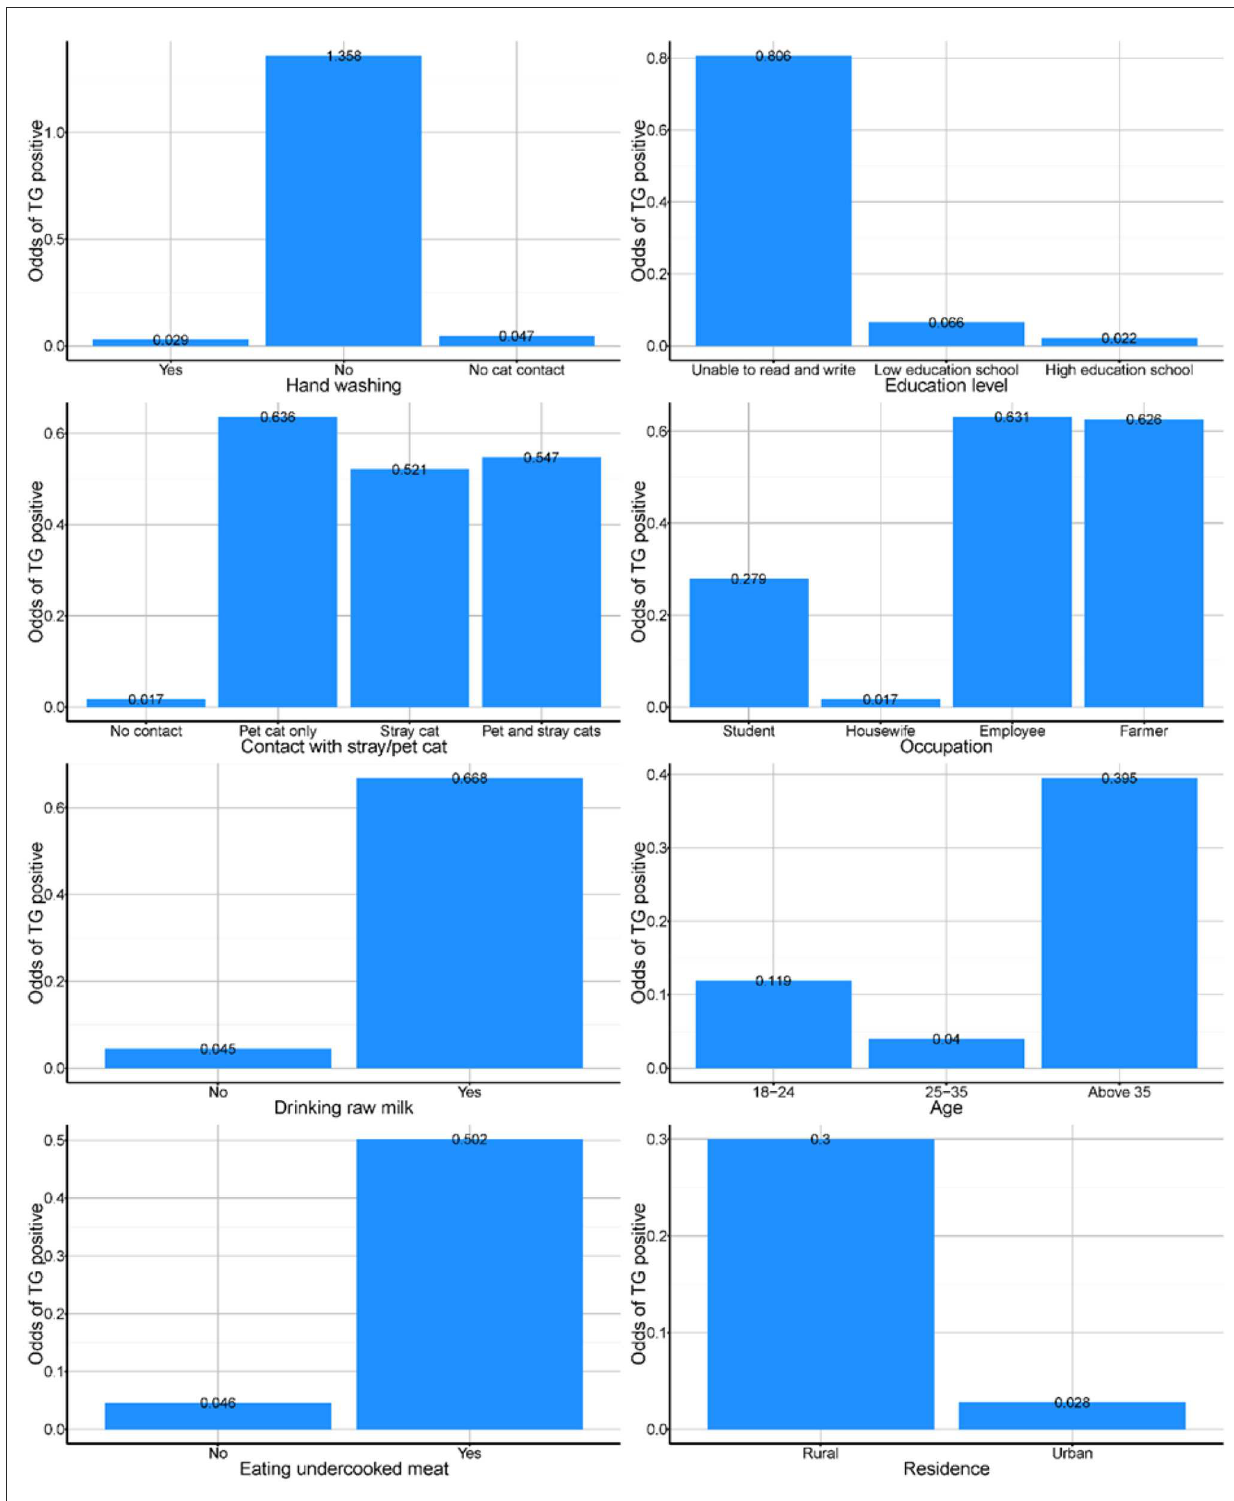
FIGURE2 Partial dependency plots from the best random forest model presenting odds of toxoplasmosis among pregnant women exposed to different factors in Sharqia Governorate, Egypt.